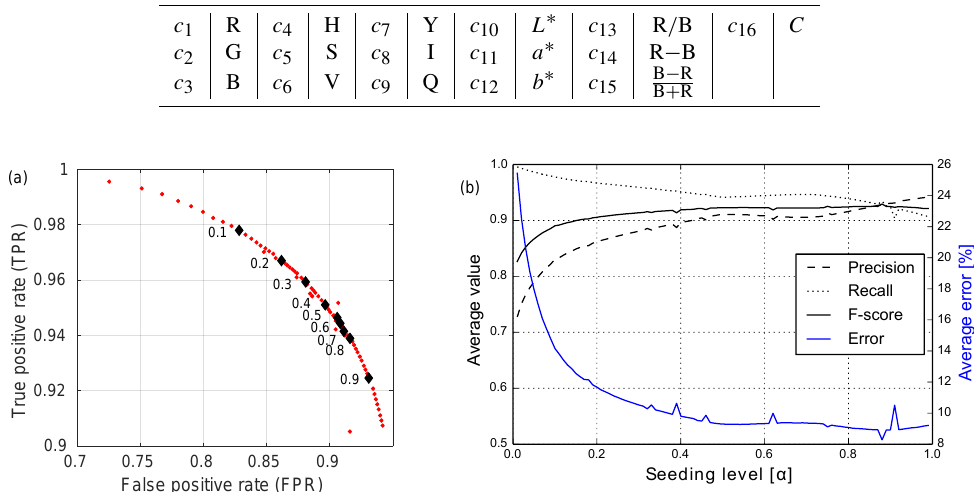
Table 1. Color spaces and components used in our analysis. We intend to find the best color channel for HDR imaging.